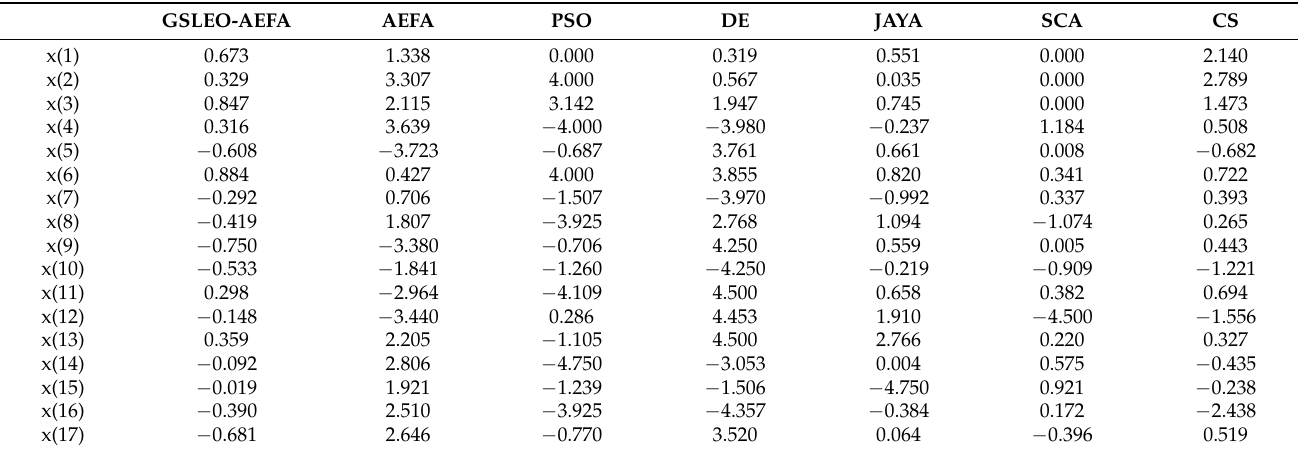
Table 10. Results Lennard–Jones Potential